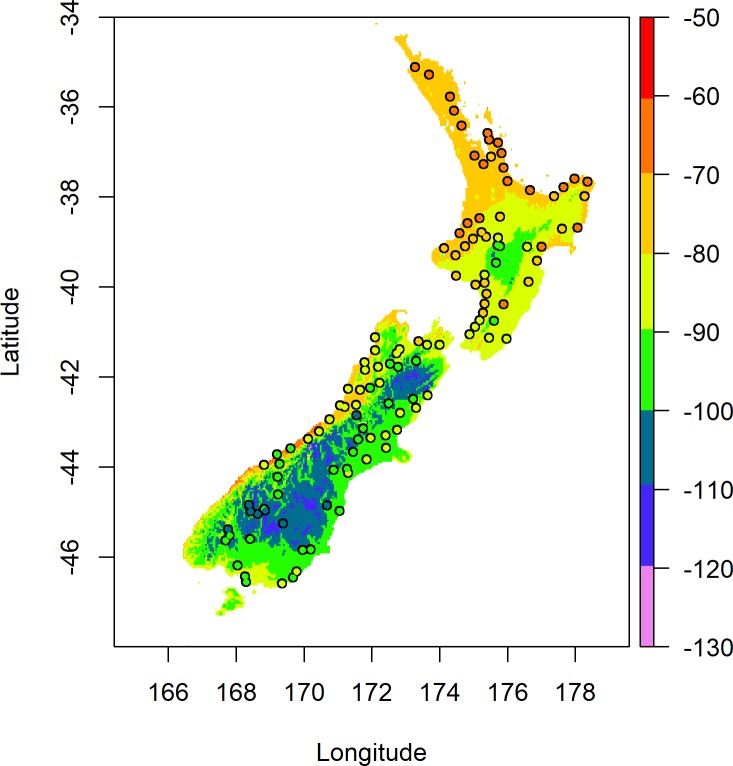
Predicted blackberry leaf δ2H values (‰) across New Zealand based on Model 1.Coloured points represent the measured δ2H values for blackberry leaves sampled from those locations.